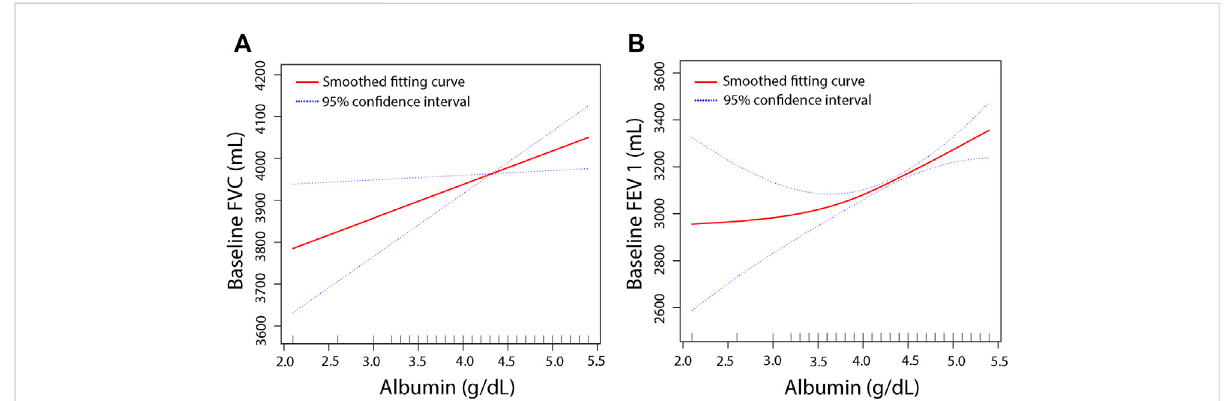
FIGURE 2 The association between serum albumin and pulmonary function. The smooth curve fi t between the variables is indicated by the red line. The fi t ’ s 95 percent con fi dence interval is represented by the blue bar. Weighted by: Full sample mobile examination center exam weight. Adjusted for, globulin (smooth), age (smooth), gender, education level, race, surgery (yes, no), respiratory disease (yes, no), cigarette (yes, no), weight (smooth), standing height (smooth), diastolic blood pressure (smooth), systolic blood pressure (smooth), glucose, serum (smooth), cholesterol (smooth), creatinine (smooth), ALT(smooth),totalcalcium(smooth),sodium (smooth), potassium(smooth). (A) Solidlineplotofcurve fi twhosemainvariables are baseline albumin and FVC. (B) Solid line plot of curve fi t whose main variables are baseline albumin and FEV